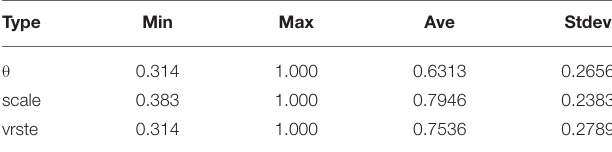
TABLE 2 | Results DEA competitiveness